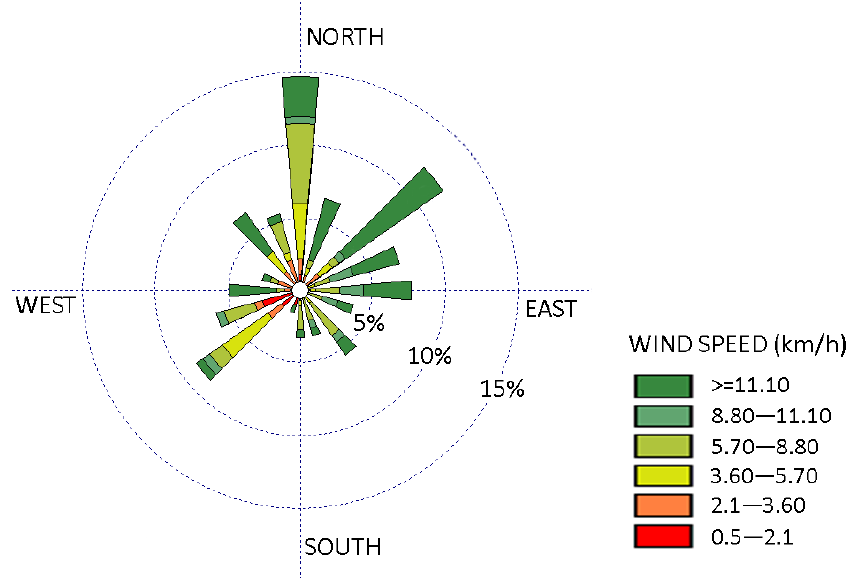
Figure 12. Wind rose diagram. Euboea 3–11 August 2021. Wind direction (blowing to) [81]. Image created by WRPLOT View [82].